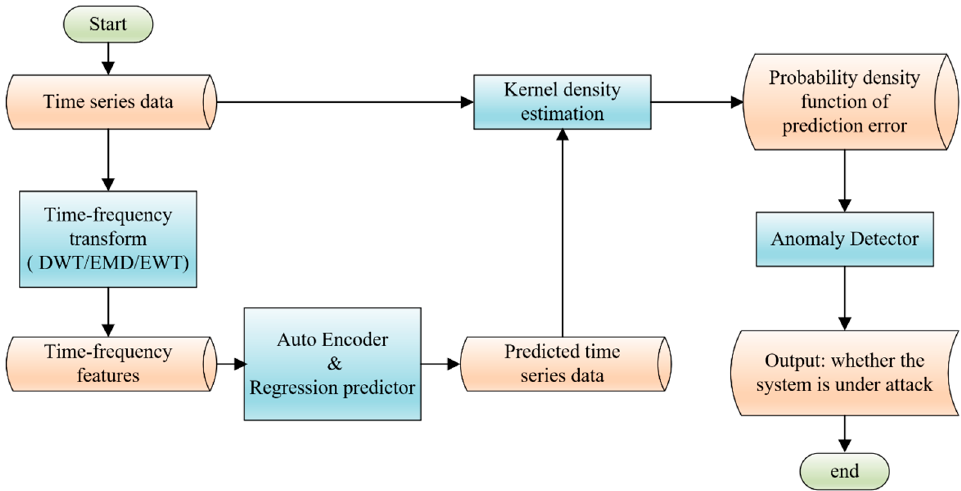
Figure 9. Procedure of AE-KDE-based anomaly detection.